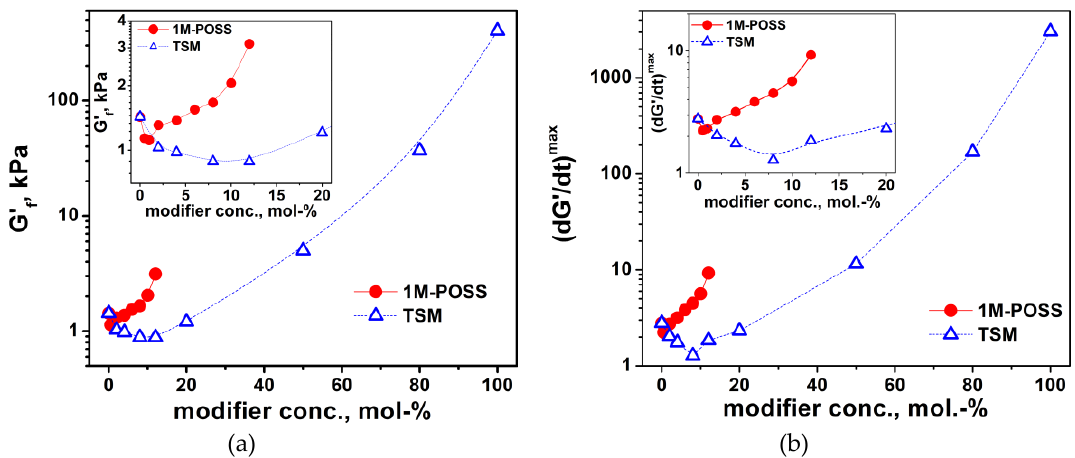
Figure 9. ( a ) Final storage modulus, G f ’ , and ( b ) the maximum value of G’ derivative (dG’/dt) max as a function of the modifier content. Reaction temperature is 40 °C; the lines are eye guides.